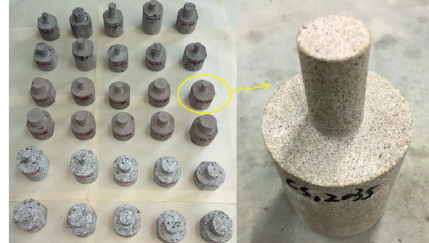
Figure 2: Core columns